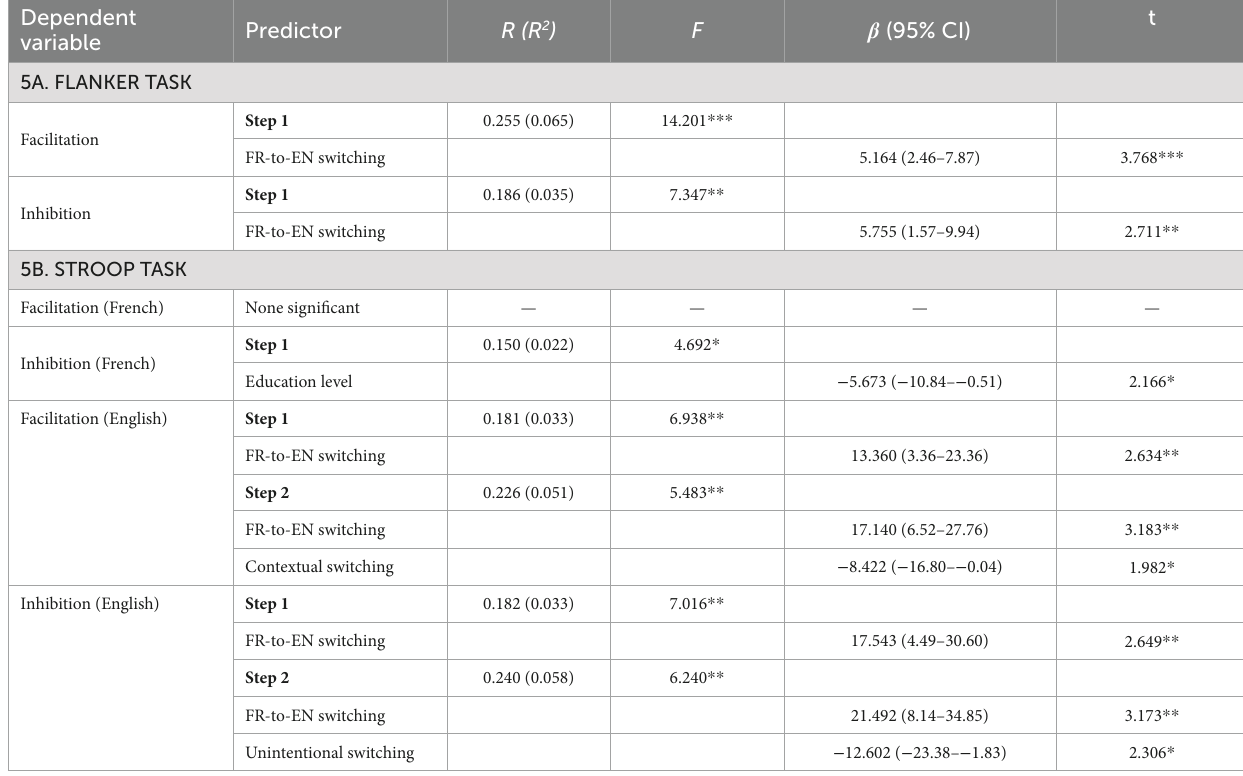
TABLE 5 Summary of the multiple regression statistics for the (A) FLANKER task and (B) STROOP task. Dependent variable